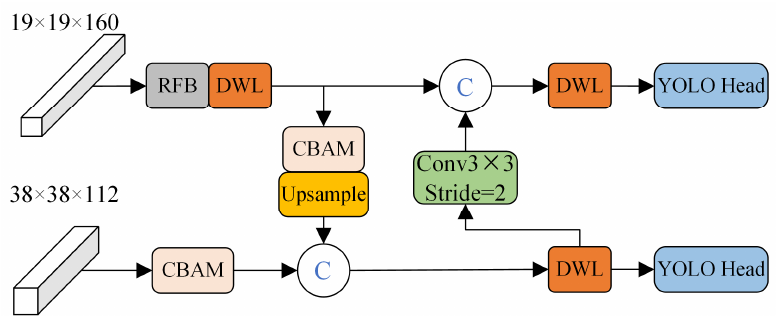
Figure 9. The structure of the improved